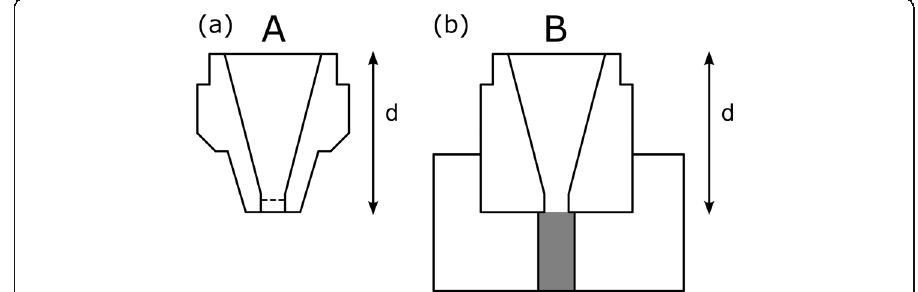
Fig. 2 Nozzle heads used in this study: a standard nozzle head A with an outlet diameter of 4 mm, b nozzle head B designed with relaxation volume and an outlet diameter of 5 mm. The scale d is the same for both nozzles. Nozzle head B has a relaxation volume with a length of about 16 mm (grey area). All distances between the jet and the calorimetric probe are in respect to the lower end of the correspondent nozzle head. For nozzle head A the distance between the probe and the excitation volume is the same as the one between the probe and the nozzle head. For nozzle head B the length of the relaxation volume of about 16 mm has to be added for this